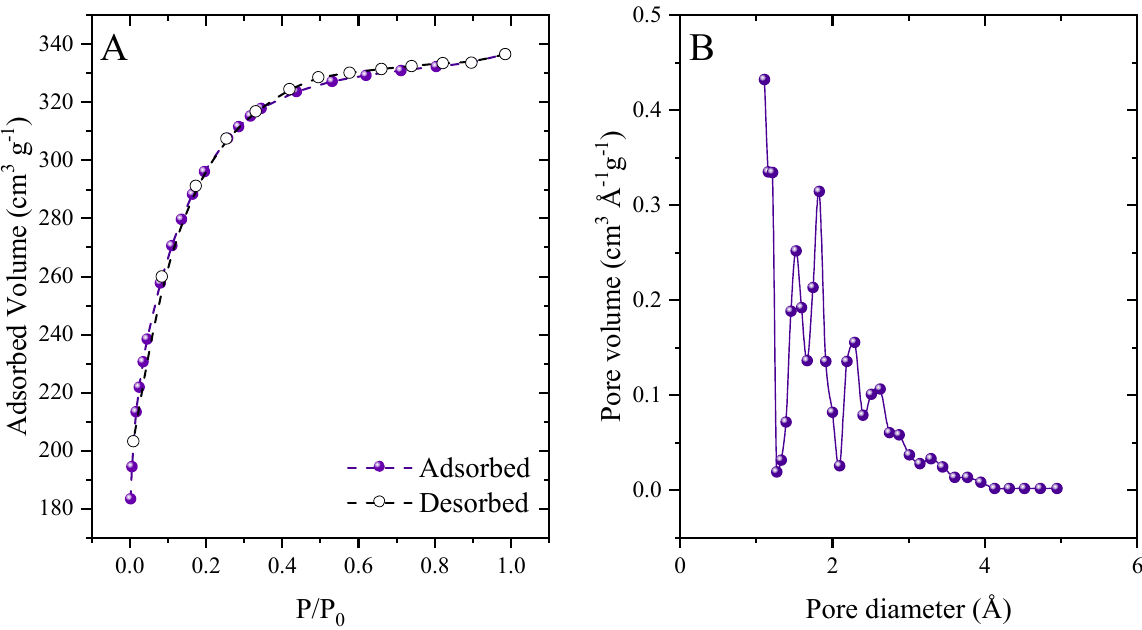
Figure 5. N 2 adsorption–desorption isotherms ( A ) and desorption pore size distribution ( B ).